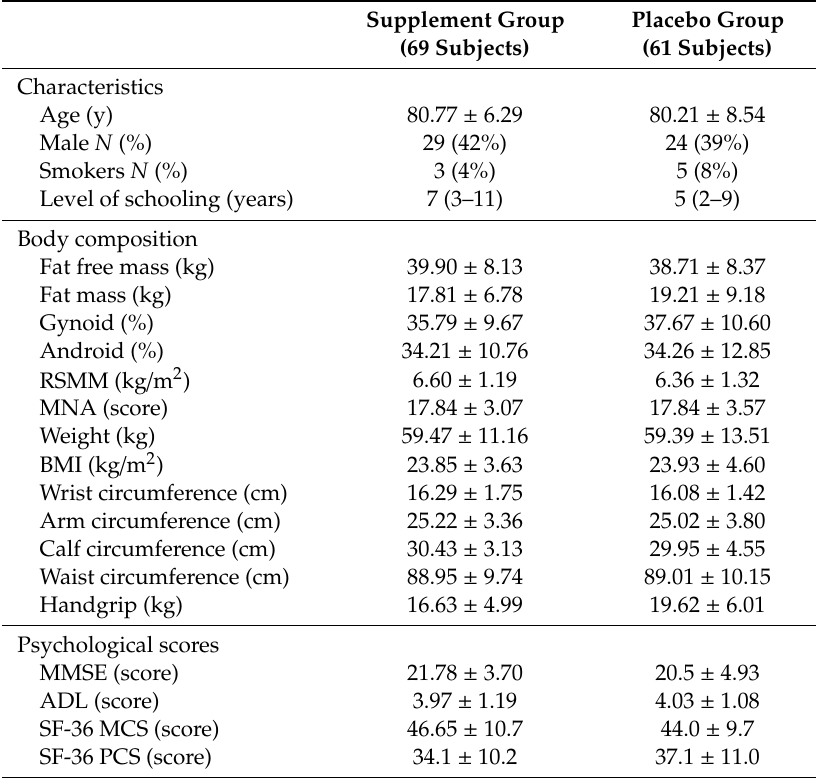
Table 1. Baseline characteristics of the participants 1